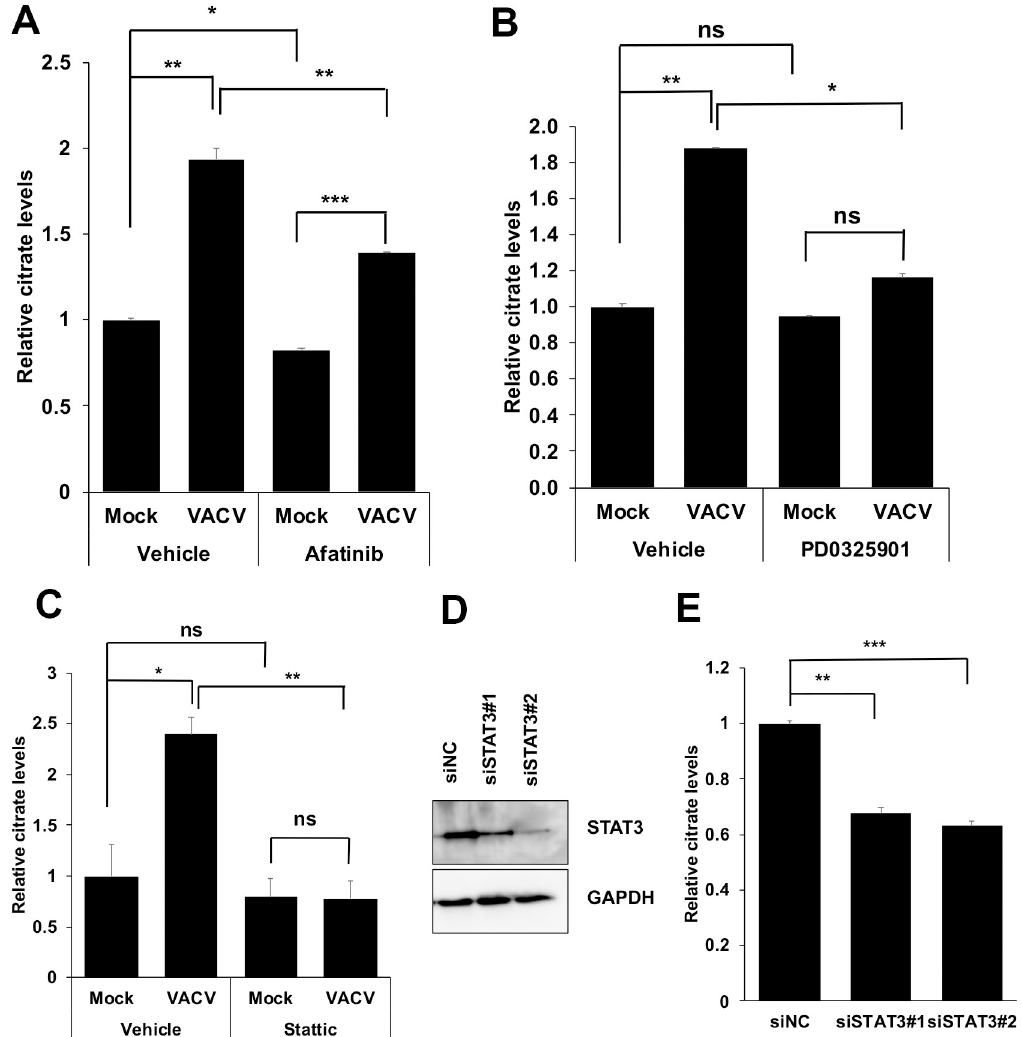
Fig 6. Inhibition of the STAT3 pathway and its upstream signaling decreases citrate levels during VACV infection. (A) Inhibition of the EGFR pathway decreases the citrate level in VACV-infected HFFs. HFFs were infected with WT VACV at an MOI of 5 in the presence or absence of 3 μ M afatinib. The citrate level was measured at 4 hpi. (B) Inhibition of the MAPK pathway decreases the citrate level during VACV infection. HFFs were infected with WT VACV at an MOI of 5 in the presence or absence of 20 μ M PD0325901. The citrate level was measured at 2 hpi. (C) Inhibition of the STAT3 pathway decreases the citrate level in VACV-infected cells. HFFs were infected with VACV at an MOI of 5 in the presence or absence of 3 μ M stattic. The citrate level was measured at 4 hpi. (F) siRNA-mediated knockdown of STAT3. HFFs were transfected with a negative control siRNA or two specific siRNA targeting STAT3 for 48 h. Western blotting analysis was performed to measure the level of STAT3. (G) siRNA-mediated knockdown of STAT3 decreases citrate level during VACV infection. HFFs were transfected with indicated siRNAs for 48 h and then infected with an MOI of 5 of VACV for 4 h, and the citrate level was measured. All the infections were performed in media with glucose plus glutamine. Error bars represent the standard deviation of at least three biological replicates. ns, P > 0.05; � , P � 0.05; �� , P � 0.01; ��� , P � 0.001. One downstream signaling molecules of the EGFR-MAPK axis is the STAT3, as EGFR induced MAPK pathway is a major upstream activator of non-canonical STAT3 phosphoryla- tion at serine 727 (S727) [54,55]. Notably, stattic, an inhibitor of STAT3 activation [56], signifi- cantly reduced the increase in citrate level in VACV-infected cells but not in uninfected cells ( Fig 6C ). Chemical inhibition of the STAT3 pathway by stattic resulted in a 177-fold reduction